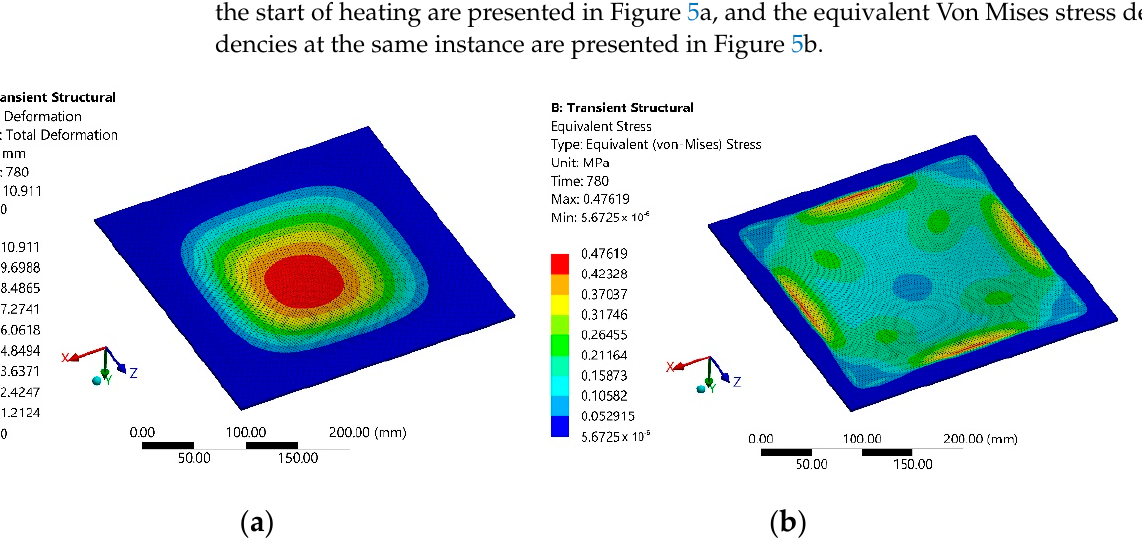
The simulation results of the total deformation of the polymer sheet after 780 s from